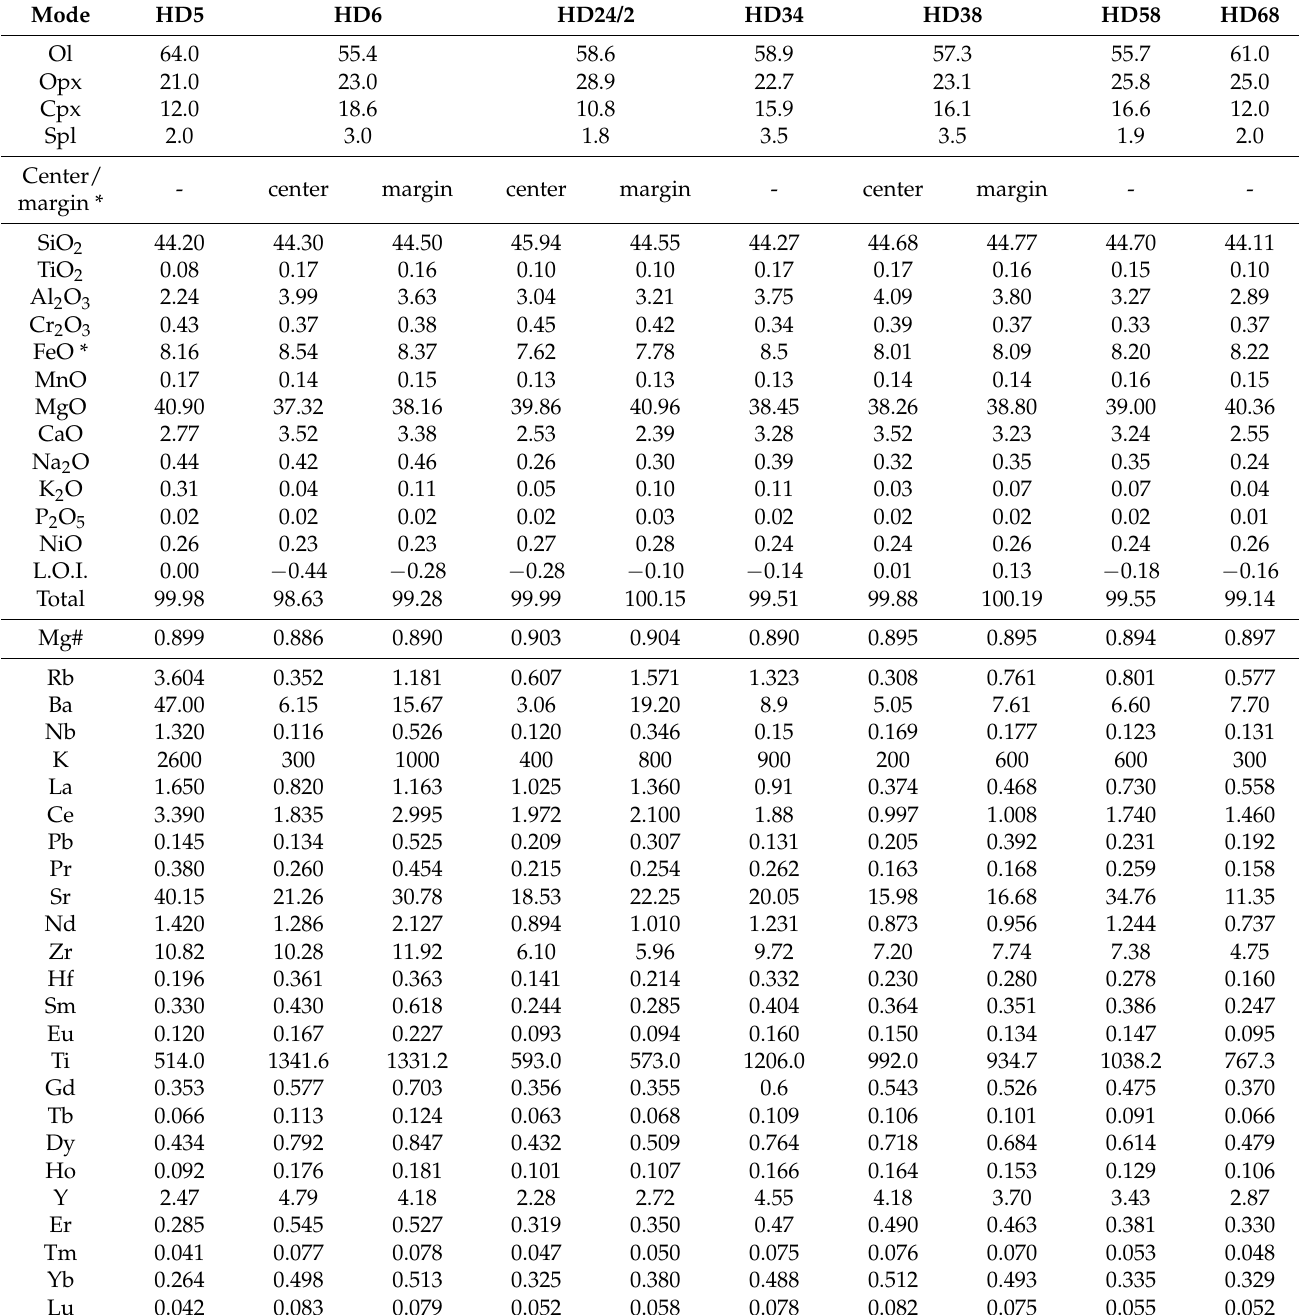
Table 2. Whole-rock and modal composition of lherzolite